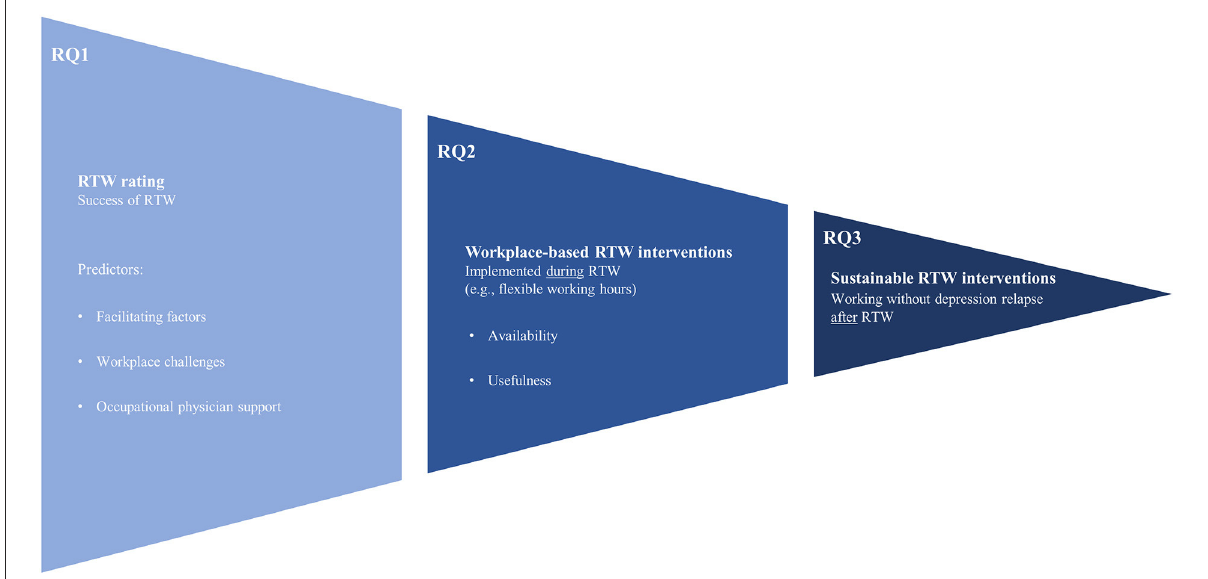
FIGURE1 Schematic illustration of return to work (RTW) process and investigated research questions